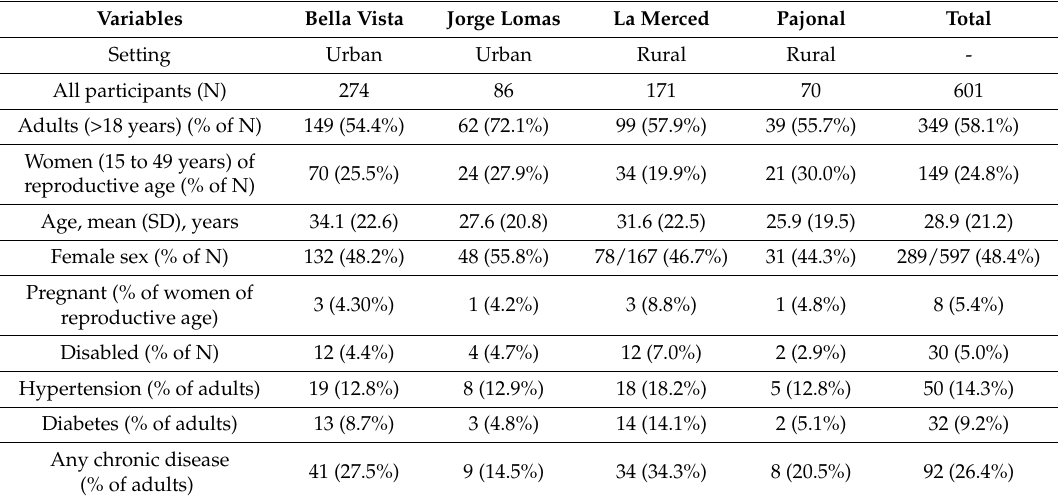
Table 1. Demographic and clinical characteristics of study participants by site. Variables Bella Vista La Merced Pajonal Setting Urban Urban Rural Rural